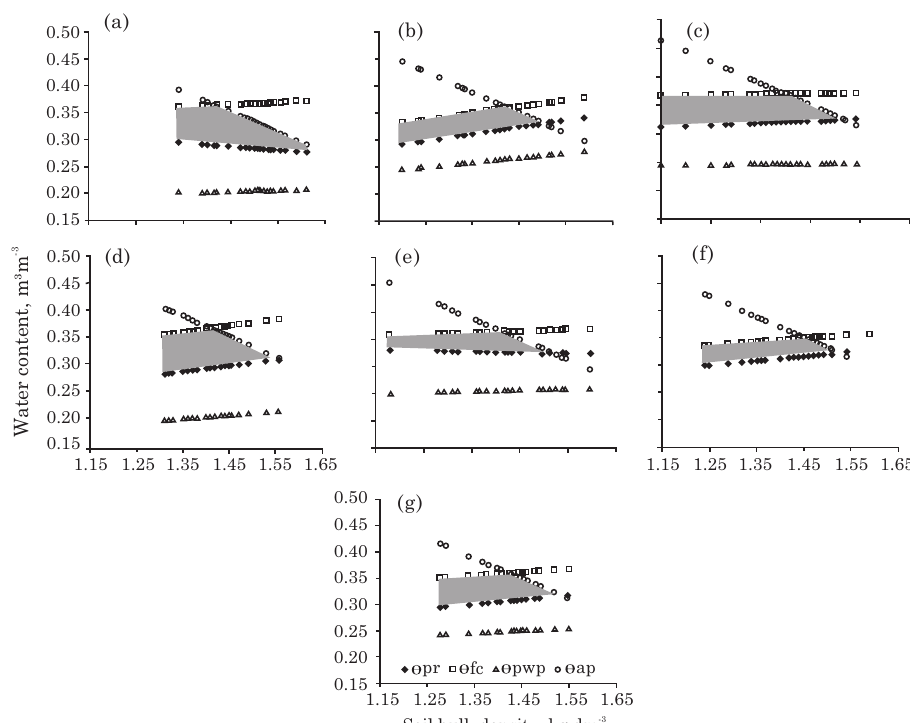
Figure 3. Least limiting water range in soil under winter crops [(a) corn, (b) sunflower, (c) oilseed radish, (d) pearl millet, (e) pigeon pea, (f) grain sorghum, and (g) sunn hemp] within soybean/corn in summer in which o = air-filled porosity, ooooo = field capacity, = soil resistance to penetration, and ∆∆∆∆∆ = permanent wilting point.